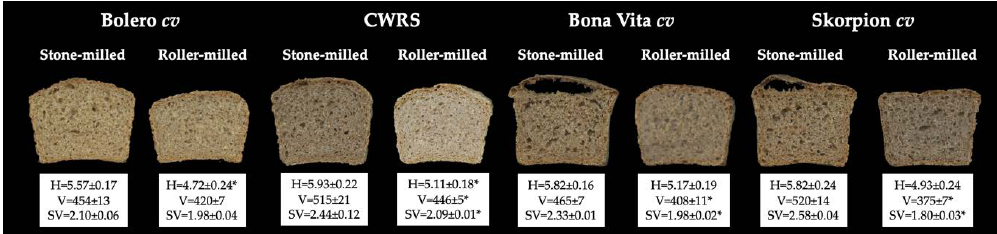
Figure 6. Effect of stone and roller milling on bread height (H; cm), volume (V; mL) specific volume (SV; mL/g). Data are presented as mean ± standard deviation. The asterisks indicate significant differences between the mean of the bread from stone and roller milled flours of each cvs (* p < 0.01). The absence of asterisk indicates a not significant difference. CWRS: commercial Canada Western Red Spring Wheat. Table 4. Cell wall-bound phenolic acids (CWBPAs), soluble phenolic acids (SPAs), antioxidant capacity (AC), xanthophylls (lutein and zeaxanthin) and total anthocyanin content (TAC) in raw material (flour), bread crust and bread crumb obtained from refined white flour, stone (SWF) and